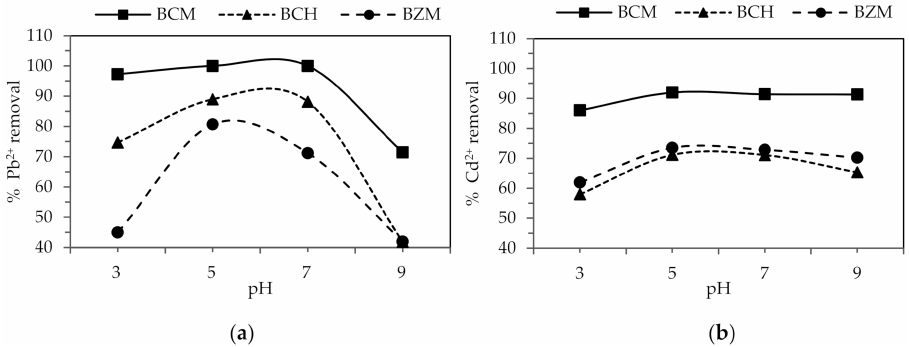
Figure 3. Percentage of ( a ) Pb 2 + and ( b ) Cd 2 + adsorption as a function of